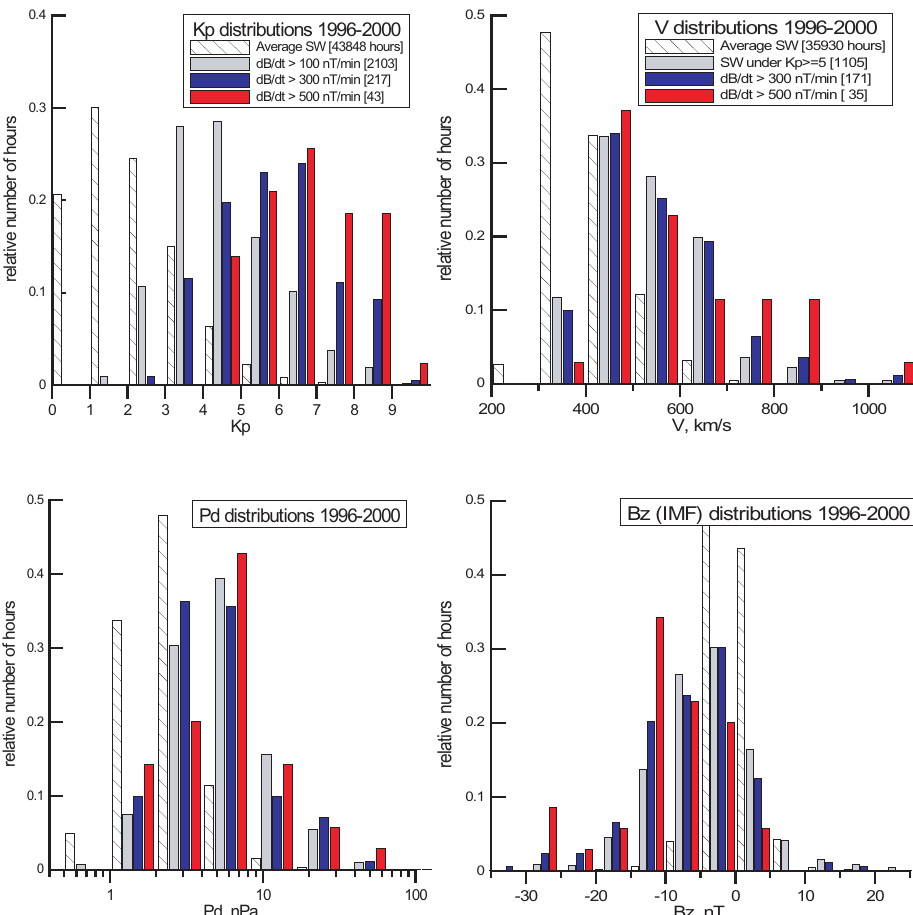
Fig. 8. Normalized occurrence distributions of hourly averaged solar wind parameters and of K p activity index constructed for the average solar wind as well as for large dB/dt events with different thresholds. Solar wind parameter distributions for K p ≥ 5 are also shown.